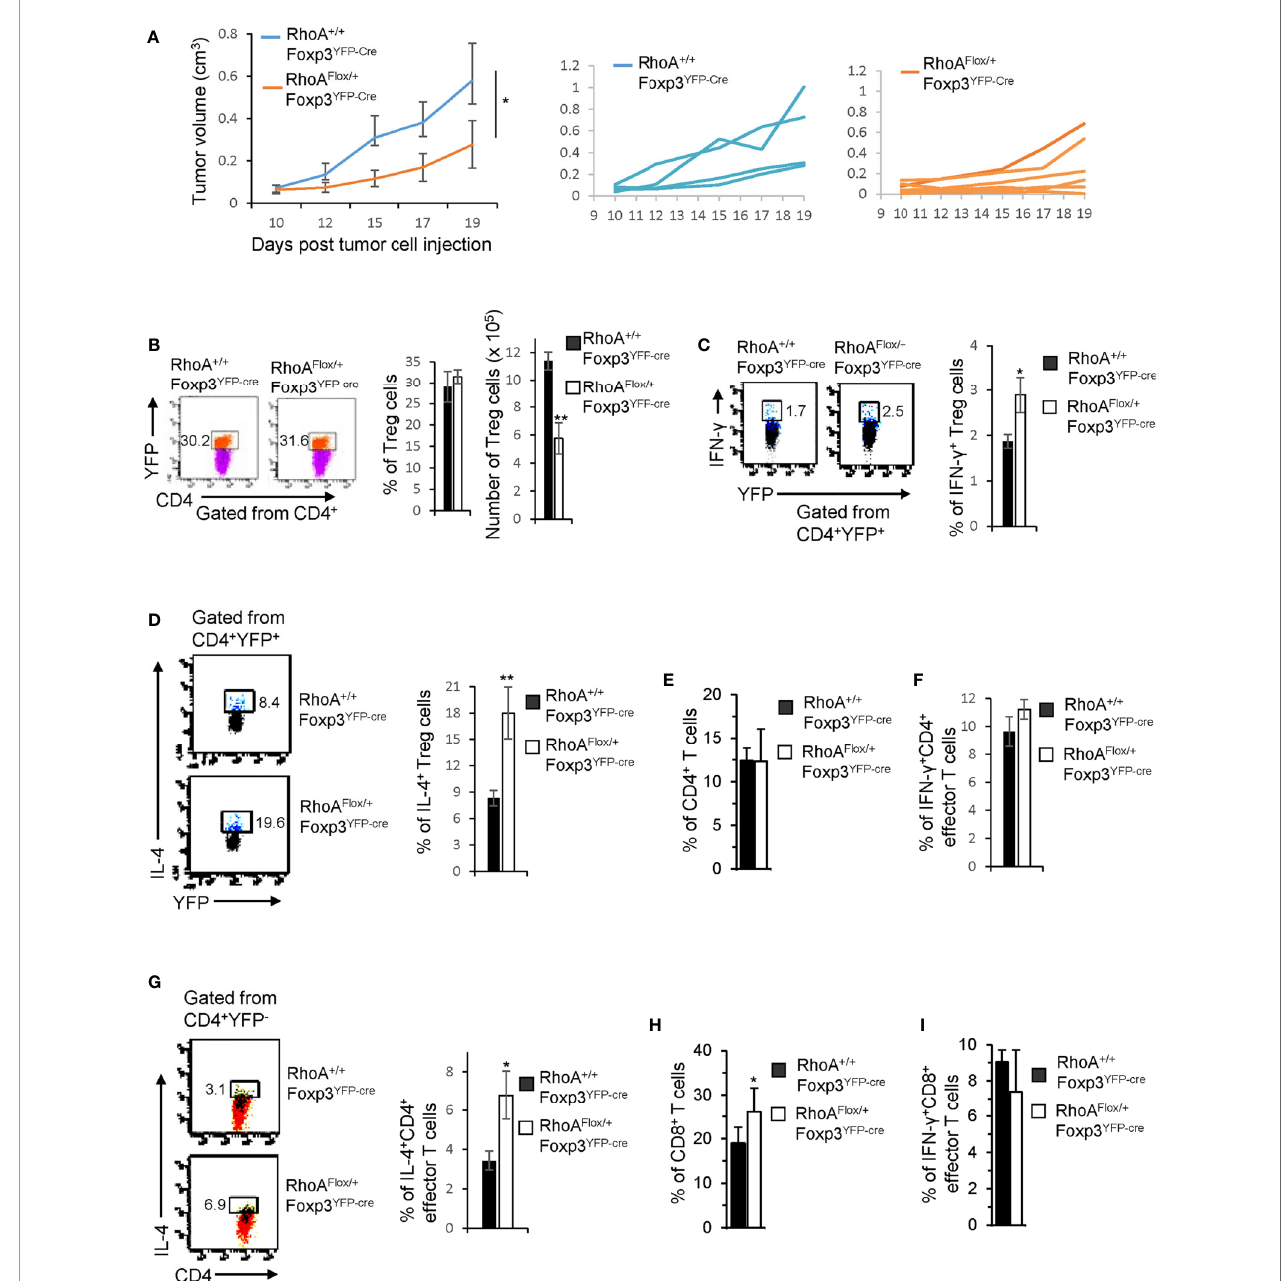
FIGURE 6 | Heterozygous RhoA deletion in Treg cells inhibits tumor growth by promoting Treg cell plasticity. (A) Left, average tumor growth of MC38 mouse colon cancer cells in RhoA +/+ Foxp3 YFP-Cre and RhoA Flox/+ Foxp3 YFP-Cre mice. Middle, tumor growth in individual RhoA +/+ Foxp3 YFP-Cre mice. Right, tumor growth in individual RhoA Flox/+ Foxp3 YFP-Cre mice. (B) Left, representative fl ow cytogram of CD4 + YFP + cells from the tumors of RhoA +/+ Foxp3 YFP-Cre and RhoA Flox/+ Foxp3 YFP-Cre mice. The numbers indicate percentages of tumor-in fi ltrating CD4 + YFP + Treg cells. Middle, average percentages of tumor-in fi ltrating CD4 + YFP + Treg cells. Right, cell numbers of tumor-in fi ltrating CD4 + YFP + Treg cells. (C) Left, representative fl ow cytogram of IFN- g staining in tumor-in fi ltrating CD4 + YFP + Treg cells. The numbers indicate percentages of tumor-in fi ltrating IFN- g + Treg cells. Right, average percentages of tumor-in fi ltrating IFN- g + Treg cells. (D) Left, representative fl ow cytogram of IL-4 staining in tumor-in fi ltrating CD4 + YFP + Treg cells. The numbers indicate percentages of tumor-in fi ltrating IL-4 + Treg cells. Right, average percentages of tumor- in fi ltrating IL-4 + Treg cells. (E) Percentages of tumor-in fi ltrating CD4 + effector T cells. (F) Percentages of tumor-in fi ltrating IFN- g + CD4 + effector T cells. (G) Left, representative fl ow cytogram of IL-4 staining in tumor-in fi ltrating CD4 + YFP - effector T cells. The numbers indicate percentages of tumor-in fi ltrating IL-4 + CD4 + effector T cells. Right, average percentages of tumor-in fi ltrating IL-4 + CD4 + effector T cells. (H) Percentages of tumor-in fi ltrating CD8 + effector T cells. (I) Percentages of tumor-in fi ltrating IFN- g + CD8 + effector T cells. n = 4-6 mice. Data are representative of two independent experiments. Error bars indicate SD. *p < 0.05, **p <